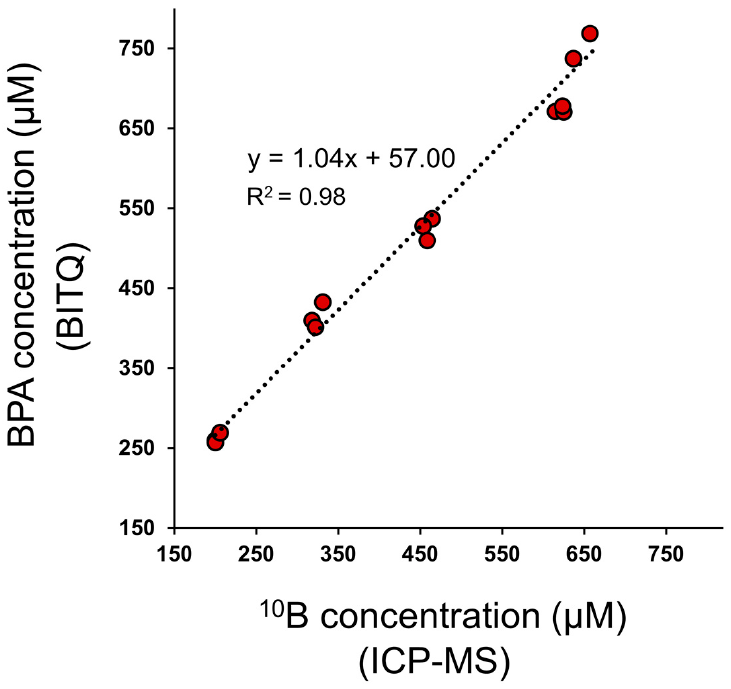
Figure 7. Linear regression analysis between the 10 B concentration determined by ICP-MS and BPA concentration determined by fluorescence analysis using BITQ in the same mouse blood.